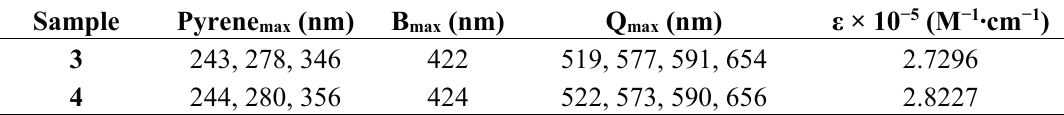
Table 1. Electronic absorption spectral profiles of dendrimers in CH 2 Cl 2 .